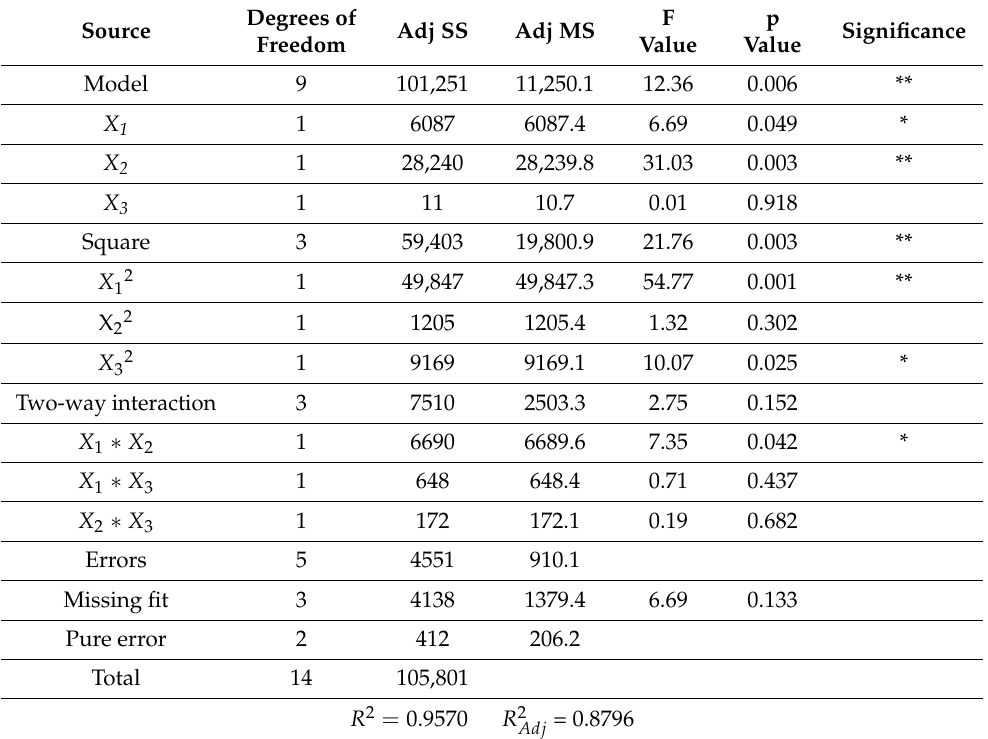
Table 6. The results of the material removal rate regression model variance